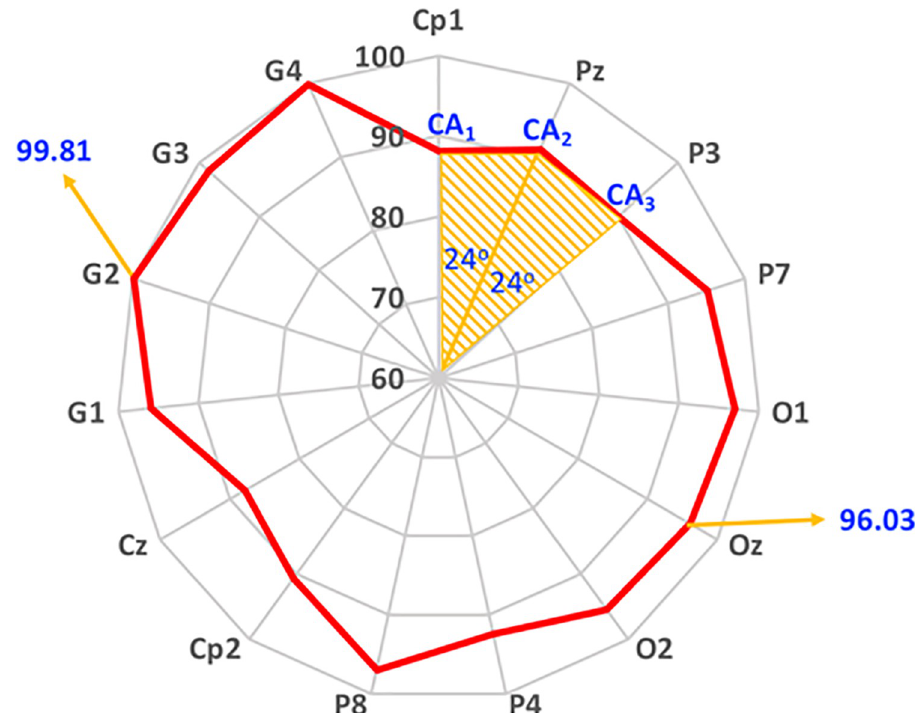
Fig 12. Area covered by radar